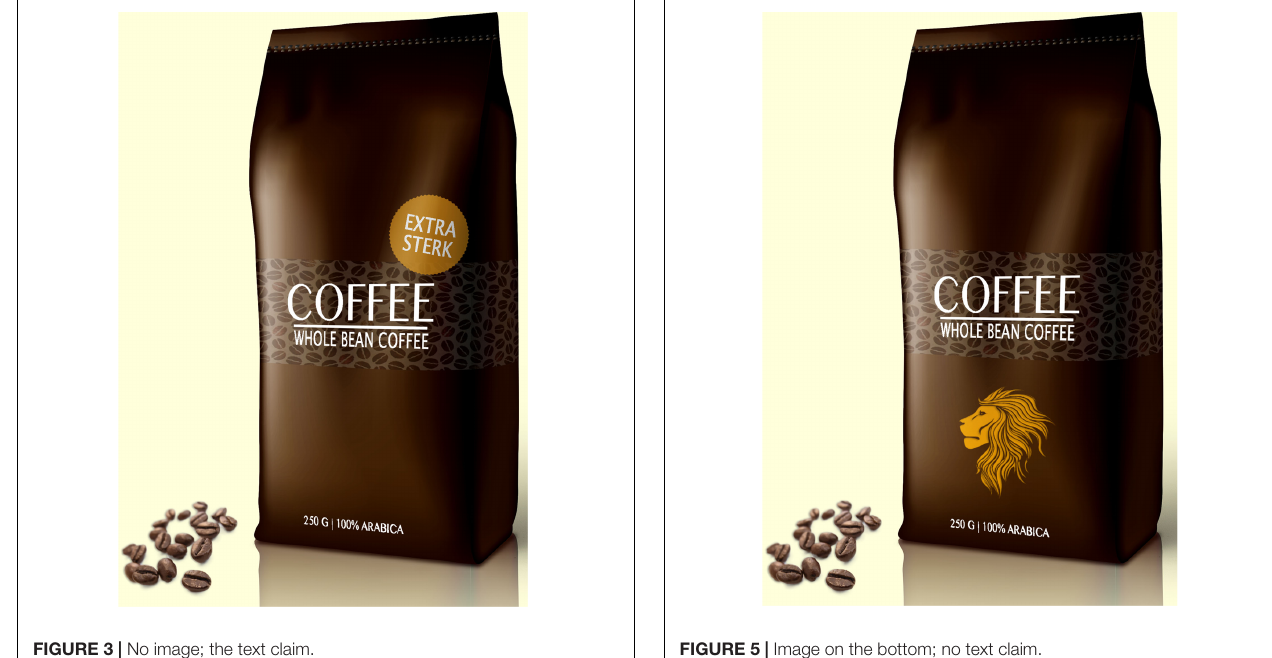
FIGURE 3 | No image; the text claim.